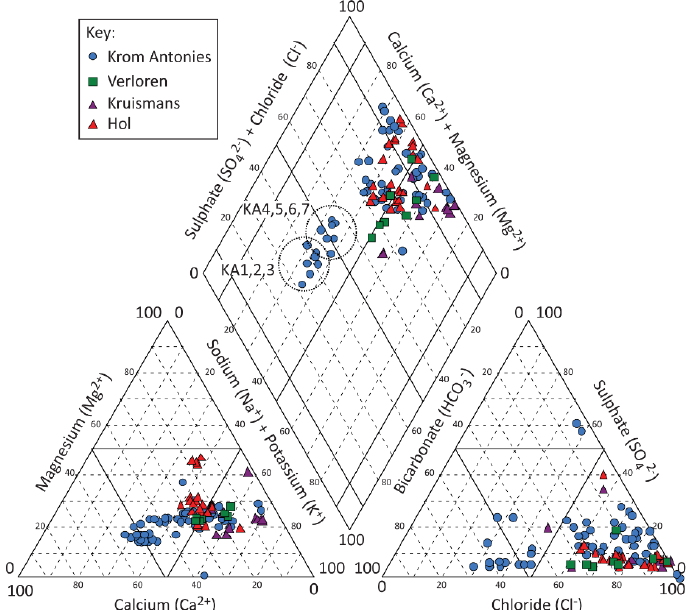
Figure 7. Piper diagram for groundwater in the study area separated into respective tributaries, showing clusters of KA 1, 2, 3 and KA 4, 5, 6, 7.